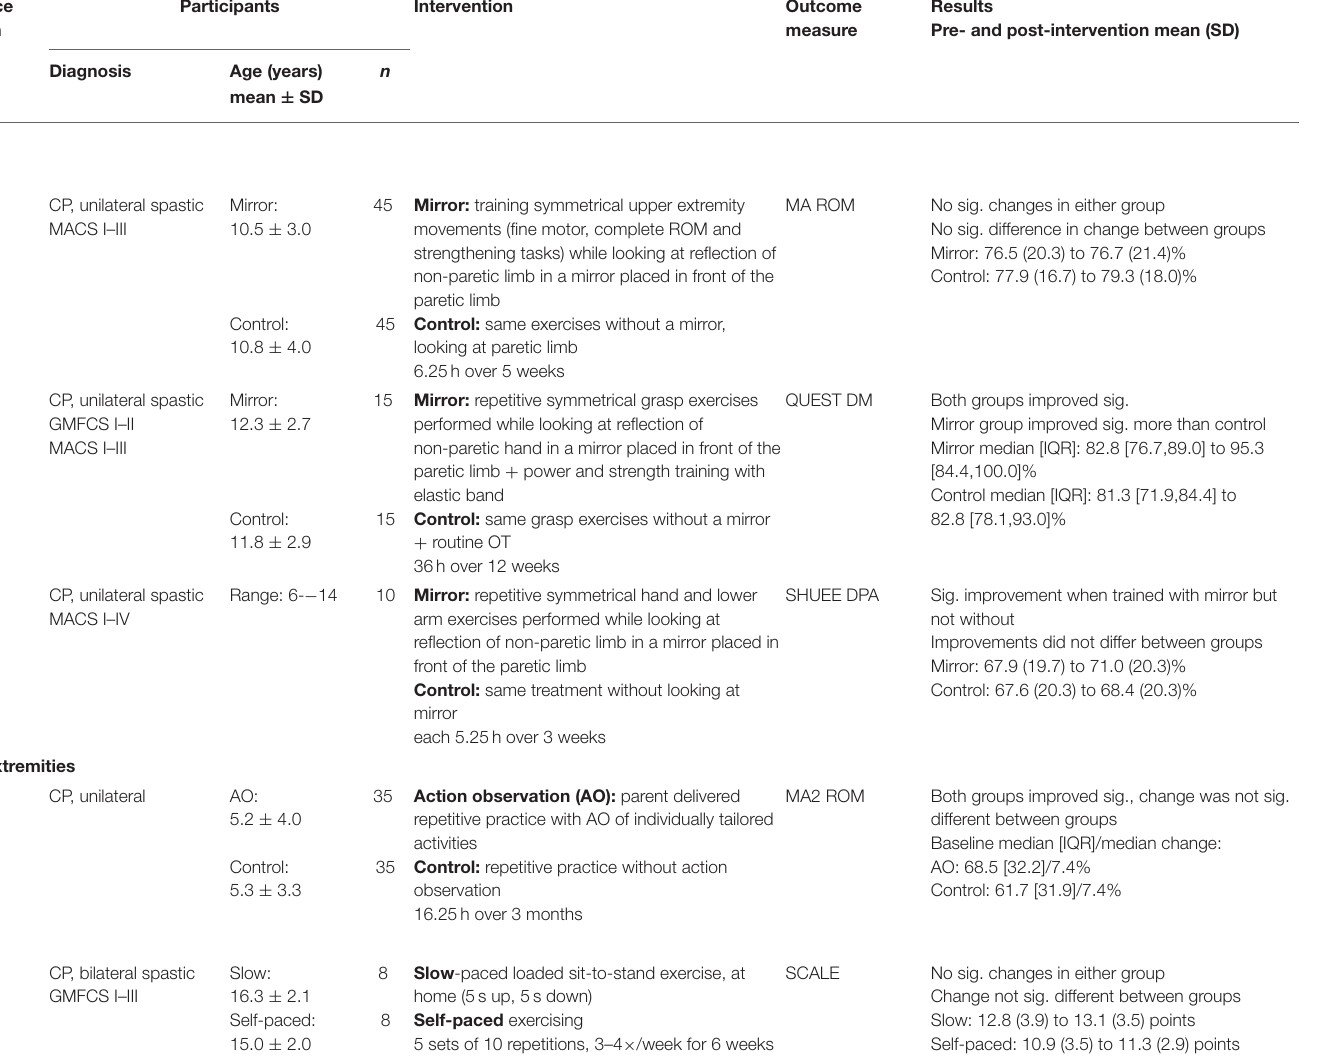
10 Mirror: repetitive symmetrical hand and lower arm exercises performed while looking at reflection of non-paretic limb in a mirror placed in front of the paretic limb Control: same treatment without looking at